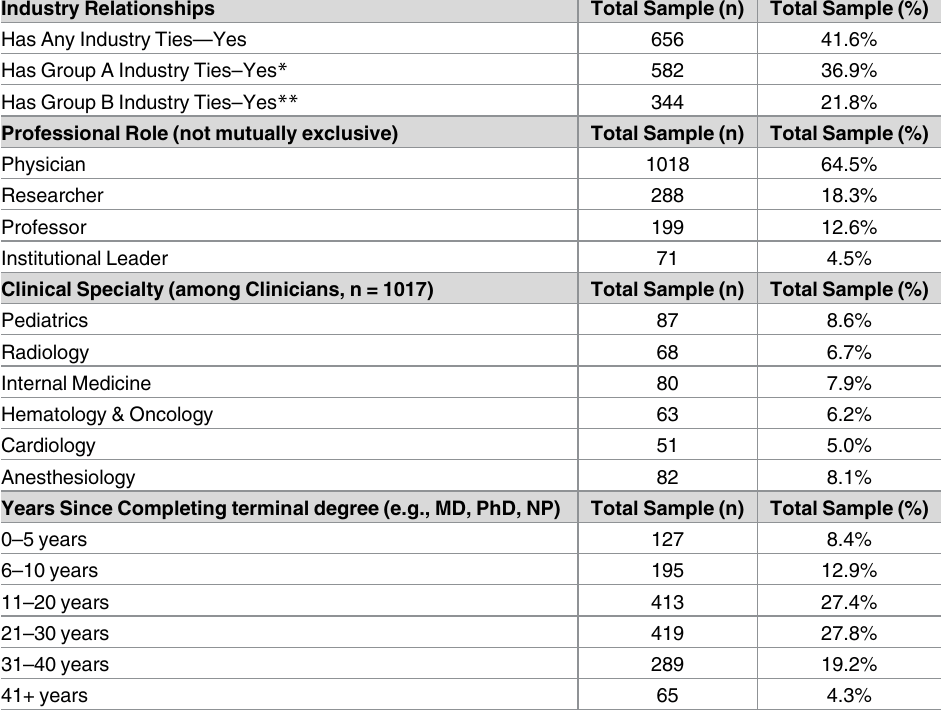
Table 3. Respondent demographics (n =